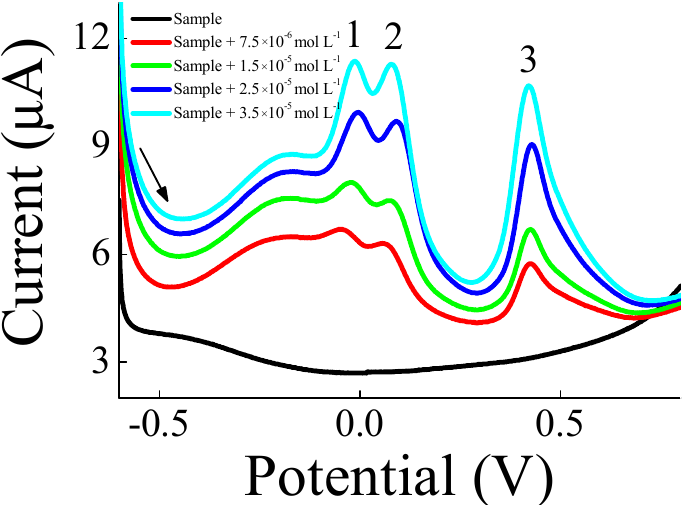
Figure 6. DP Voltammograms for water sample analysis using the method of standard addition. 1-Hydroquinone, 2-Catechol, and 3-BPA. Conditions: phosphate buffer solution 0.1 mol L − 1 pH 7.0.